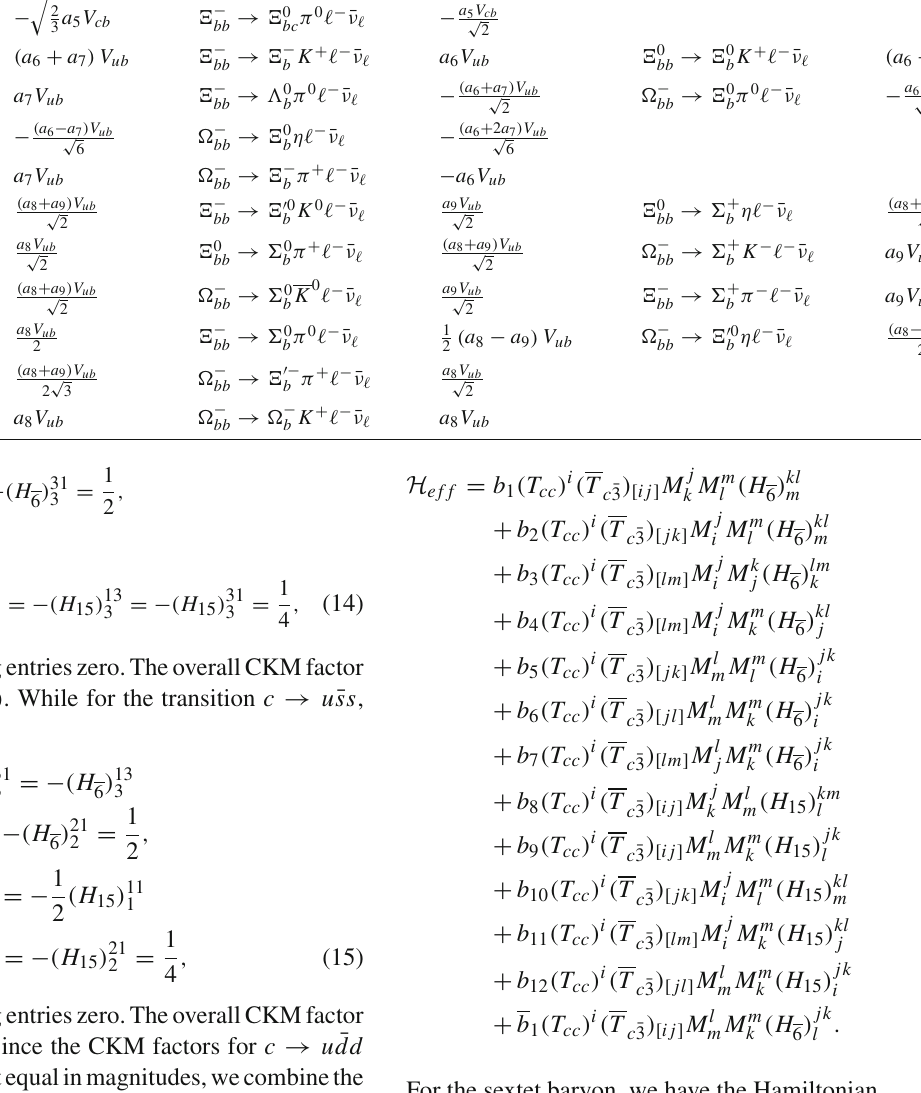
Table 5 Amplitudes for doubly bottom baryons (cid:2) bb and (cid:5) bb decays into a triplet bcq and a light meson Channel Amplitude Channel Amplitude Channel Amplitude (cid:2) 0 → (cid:2) + π 0 (cid:12) − ¯ ν (cid:12) a 5 V cb √ bc bb